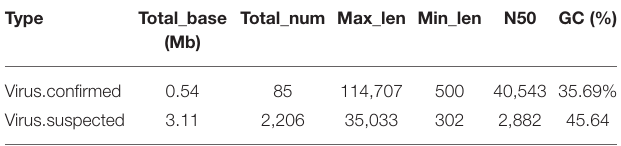
TABLE 3 | Virus sequence statistics.